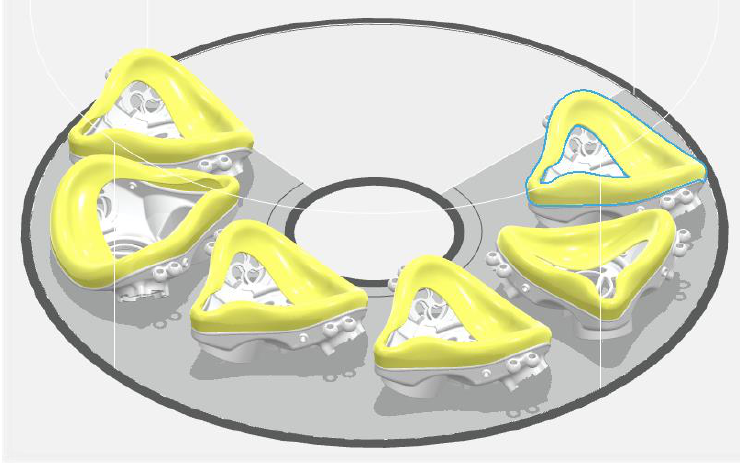
Figure 10. Screenshot of the machine tray layout, as generated by the process planning software.